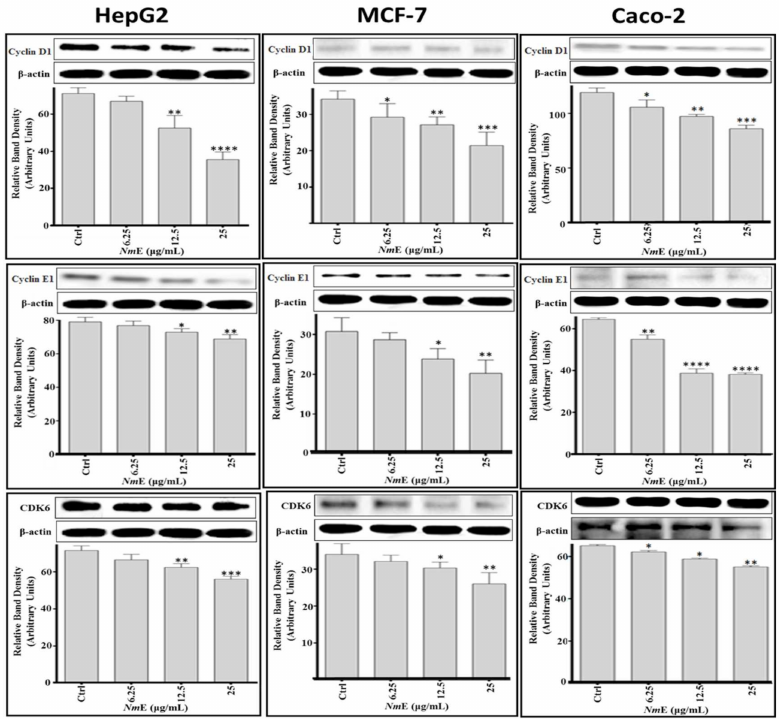
Figure 11. Effects of Nm E on protein expression of Cyclin D1, Cyclin E1, and in HepG2, MCF- 7, and Caco-2 cancer cells, which were treated with each Nm E concentration and harvested 48 h after treatments. The immunoblots shown are representative of three independent experiments, which all gave similar results, only representative, cropped, and unedited images are provided here. Bars represent the means ± SD. * p < 0.05, ** p < 0.01, *** p < 0.001 and **** p <0.0001 vs. control (DMSO-treated)